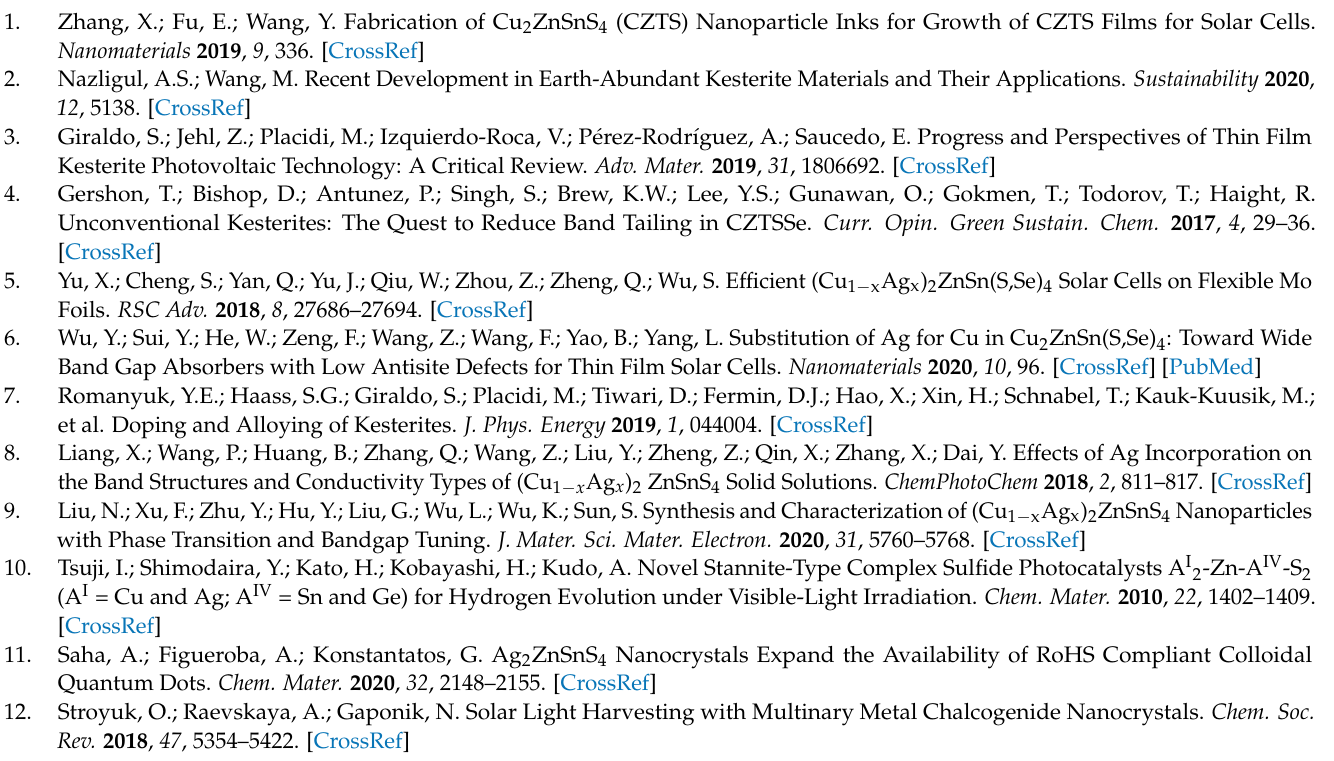
514.7 nm (b), and 633 nm (c), Figure S4: Raman spectra of Ag-S and Ag-Zn-S NCs at λ exc = 532 nm (a), 638 nm (b), and 785 nm (c), Figure S5: Raman spectra of Ag 2 ZnSnS x NC series ( λ exc = 514.7 nm), Figure S6: Representative high-resolution XPS spectra of Ag 2 ZnSnS x NCs in the range of S2p (a), Zn2p (b), C1s (c), O1s (d)